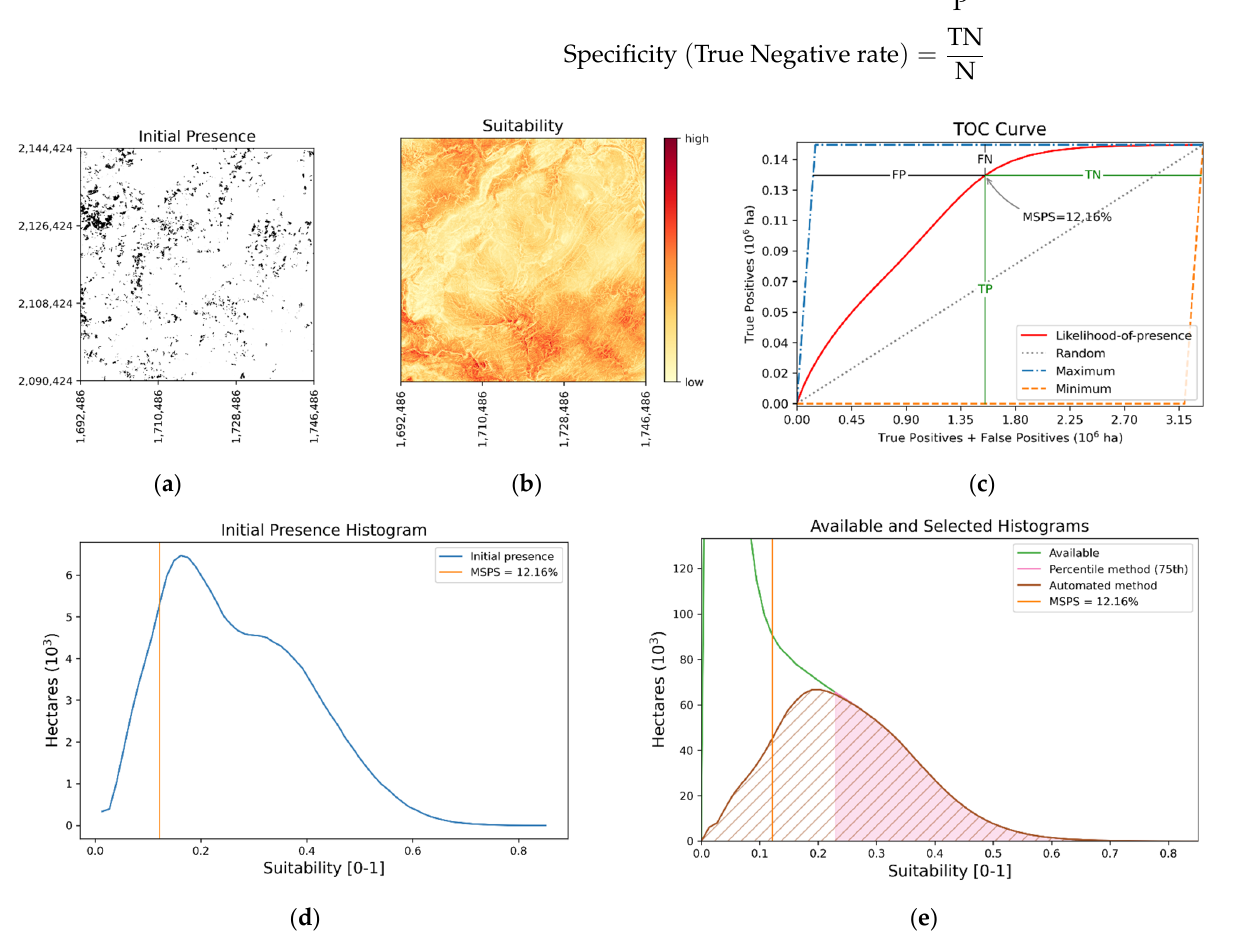
Figure 2. 54 km × 54 km region (introduced Figure 1; axes units are projected coordinates in meters) demonstrating ( a ) presence of the category Corn in the starting land cover; ( b ) corresponding likelihood/suitability values; ( c ) TOC curve derived from presence and suitability over the entire region; ( d ) histogram (pixel counts vs. values) for suitability values corresponding with initial presence; ( e ) histogram showing pixels selected from all available (green) for potential landscape expansion of Corn under old (pink) and new (brown) methods.